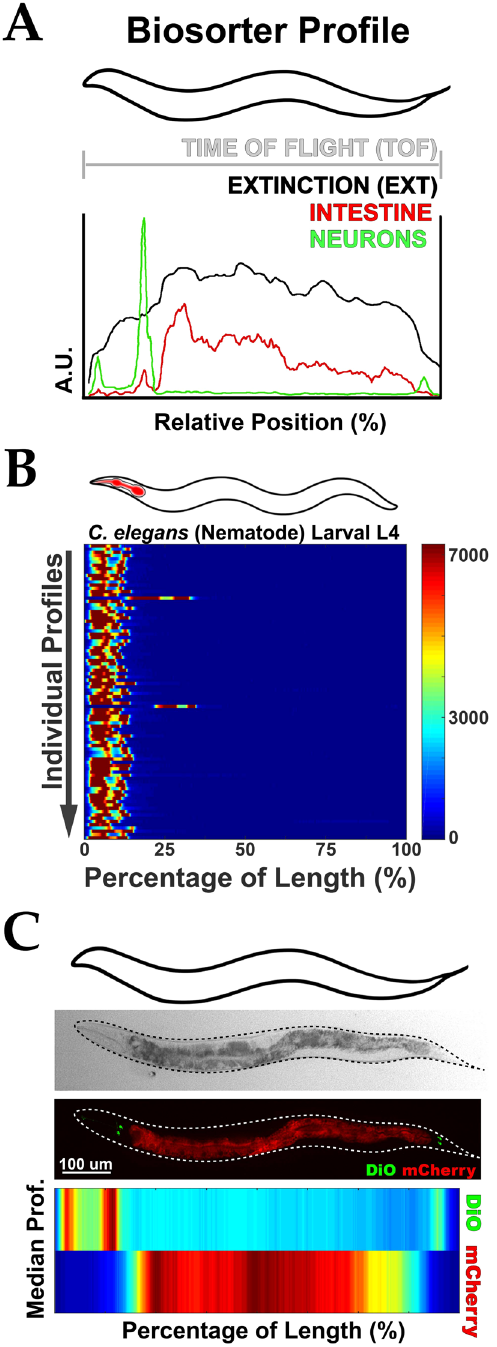
Figure 1. Algorithm to align biosorter data and derive positional information. ( A ) Representative profile for a single nematode displaying longitudinal information in: Extinction (Black) and tissue-specific fluorescent signals (Green = Neurons, Red = Intestine). Anterior is to the left. “A.U.” = Arbitrary Units. ( B,C,E,F ) Illustration of orientation algorithm devised to align animals. Example shows individual profiles (Y axis) represented as in ( A ) with signal intensity plotted as a function of the animal’s length (X axis). Tissues have been labeled (red in cartoons above) to enable orientation of nematodes ( B ). Data is shown in a heat map with Red as the most signal and Blue as the least. ( D ) Demonstration of an average profile algorithm following alignment. (Top) Representative micrographs of transgenic worms analyzed below with intestine (Red, vha-6p::mCherry::HDEL ) and sensory neurons (DiO, Green) fluorescently labeled. Worms are oriented with their anterior to the left. Scale = 200 µ m. (Bottom) Median profile from 100 + animals in the Red (intestine) and Green (neurons) channels. Data is shown in a heat map with Red as the highest intensity signal and Blue, the lowest. All animals are positioned with the anterior side to the left. Plots are representative of three biological replicates and derived from n ≥ 50 organisms. Sample size ( n ) for all experiments can be found in the Supplementary Table. L.A. Daniele provided the